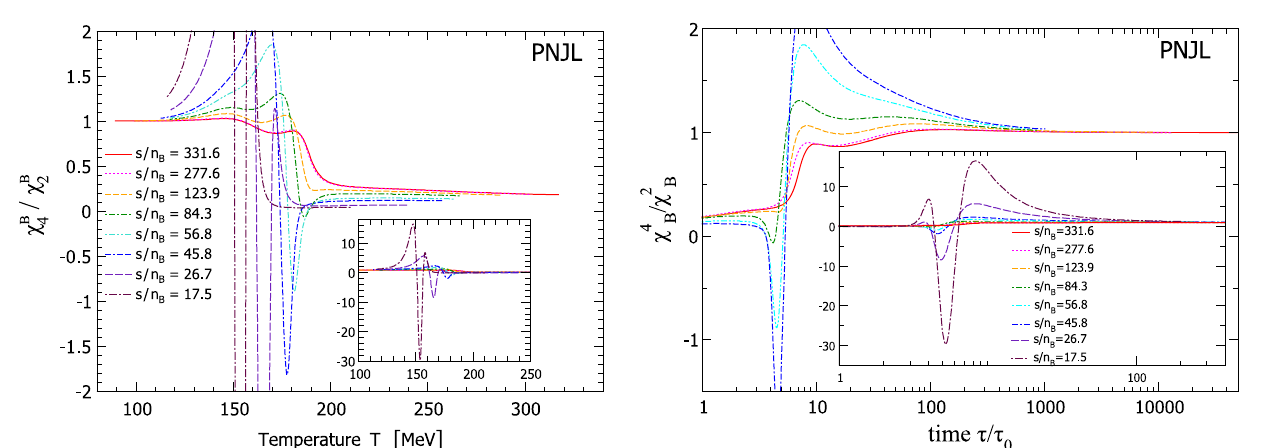
Fig. 9 The same as in Fig. 8, but for the PQM model